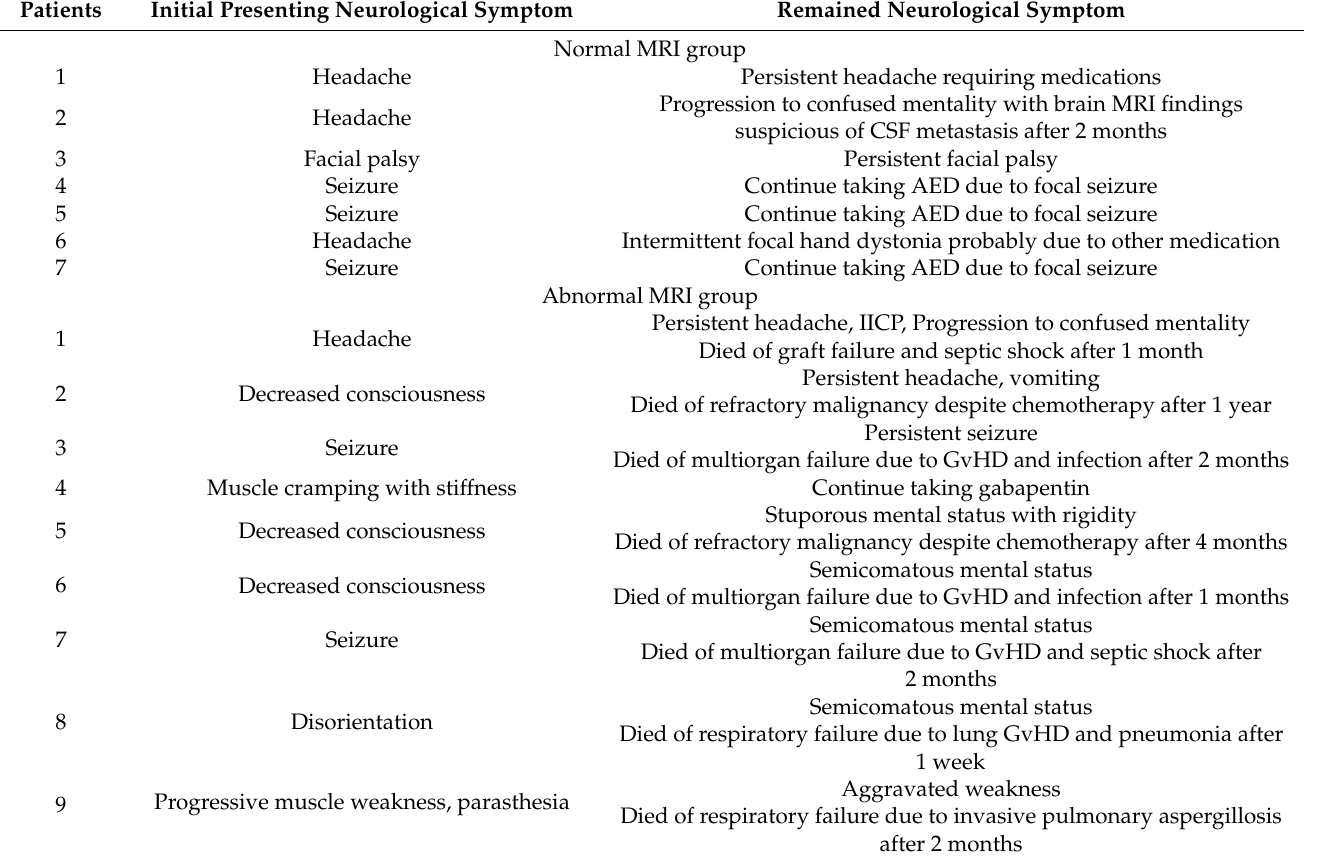
Table A2. Initial Presenting and Remained Neurological Symptom of the